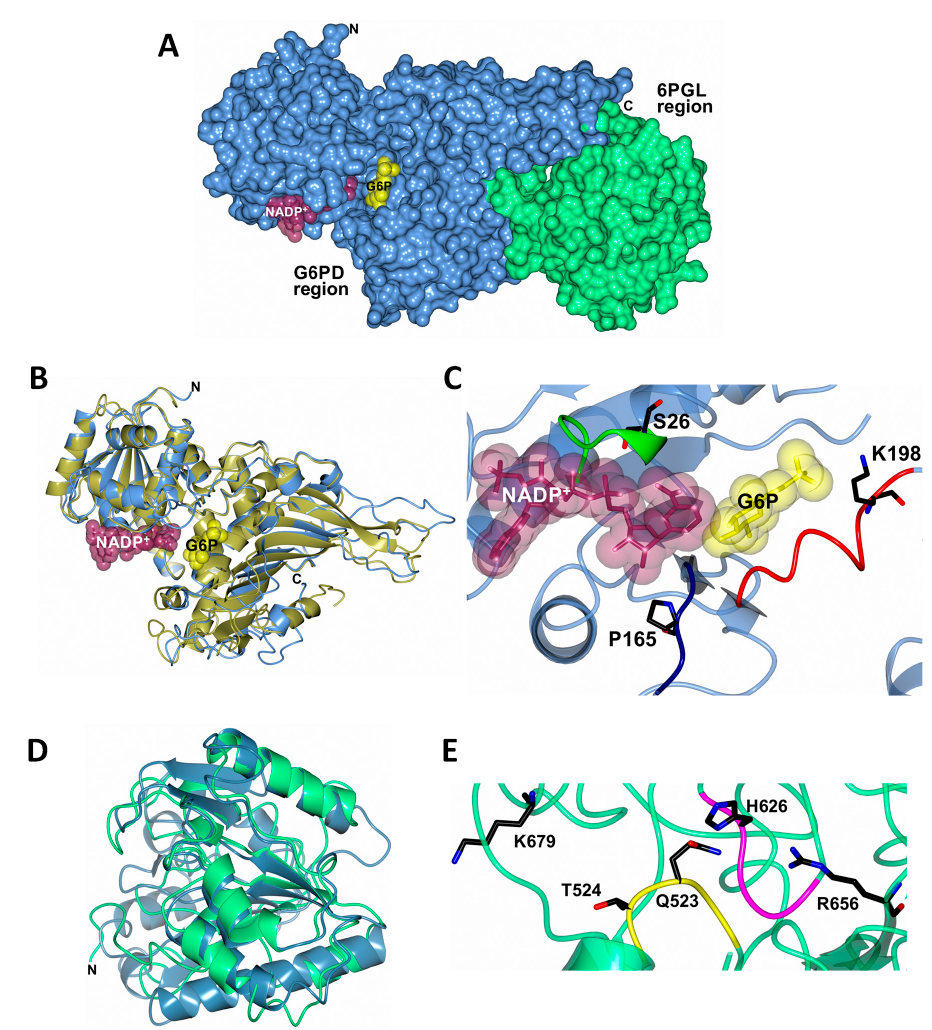
Figure 2. The homology model of the full-length TvG6PD::6PGL enzyme from T. vaginalis , ( A ) showing the N-terminal G6PD region (residues 1–483, cornflower blue) and the C-terminal 6PGL region (residues 484–712, spring green). The catalytic nicotinamide adenine dinucleotide phosphate (NADP + ) and glucose-6-phosphate (G6P) substrate (Protein Data Bank (PDB) entries 2BHL and 2BH9) are drawn as dark purple and yellow molecular surface representations, respectively. ( B ) Structural superposition of the human G6PD crystal structure (PDB entry 2BH9, gold) with the N-terminal G6PD region of the TvG6PD::6PGL model (cornflower blue). ( C ) The G6PD active site showed the conserved sequences 20-GxxGDLS-26 (green), 163-EKPxG-167 (dark blue), and 191-RIDHYLGKE–199 (red). Representative residues (S26, P165, and K198) of these conserved sequences are shown as black cylinders. ( D ) Structural superposition of the 6PGL crystal structure from Mycolicibacterium smegmatis MC2 155 (PDB entry 3OC6, steel blue) with the C-terminal 6PGL region of the TvG6PD::6PGL model (spring green). ( E ) The 6PGL active site showed the conserved sequences 521-GGQTP-525 (yellow) and 625-GHTAS-629 (magenta). Representative residues (Q523 T524, and H626) of these conserved sequences, as well as R656 and K679 residues, are shown as black